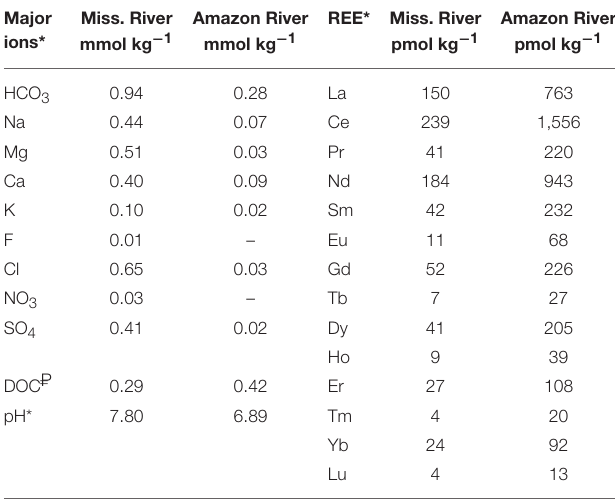
TABLE 2 | Summary of input parameters used for the WHAM VII geochemical